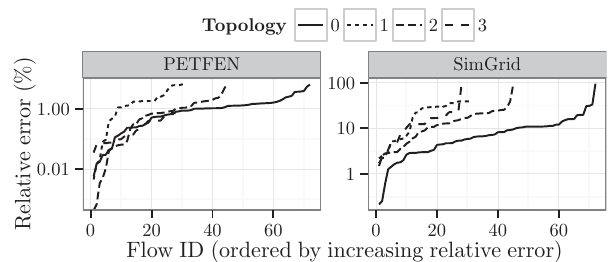
Figure 5: Relative error between the tools and OM- NeT++ on the tree topologies of Figure